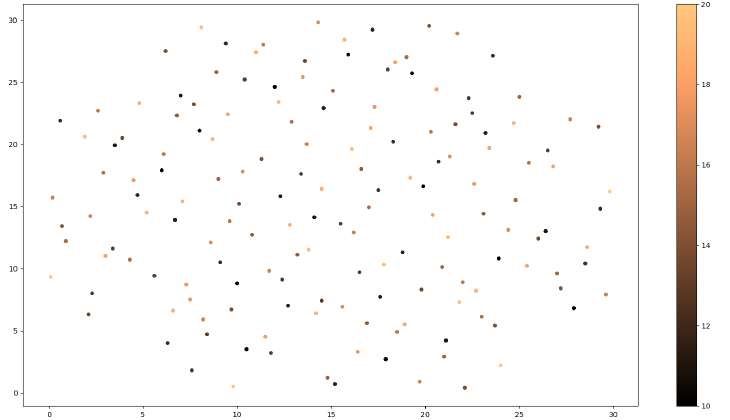
Figure 3. Two-dimensional representation of impact coordinates and fall height combinations (with different colors), based on Sobol sequences.